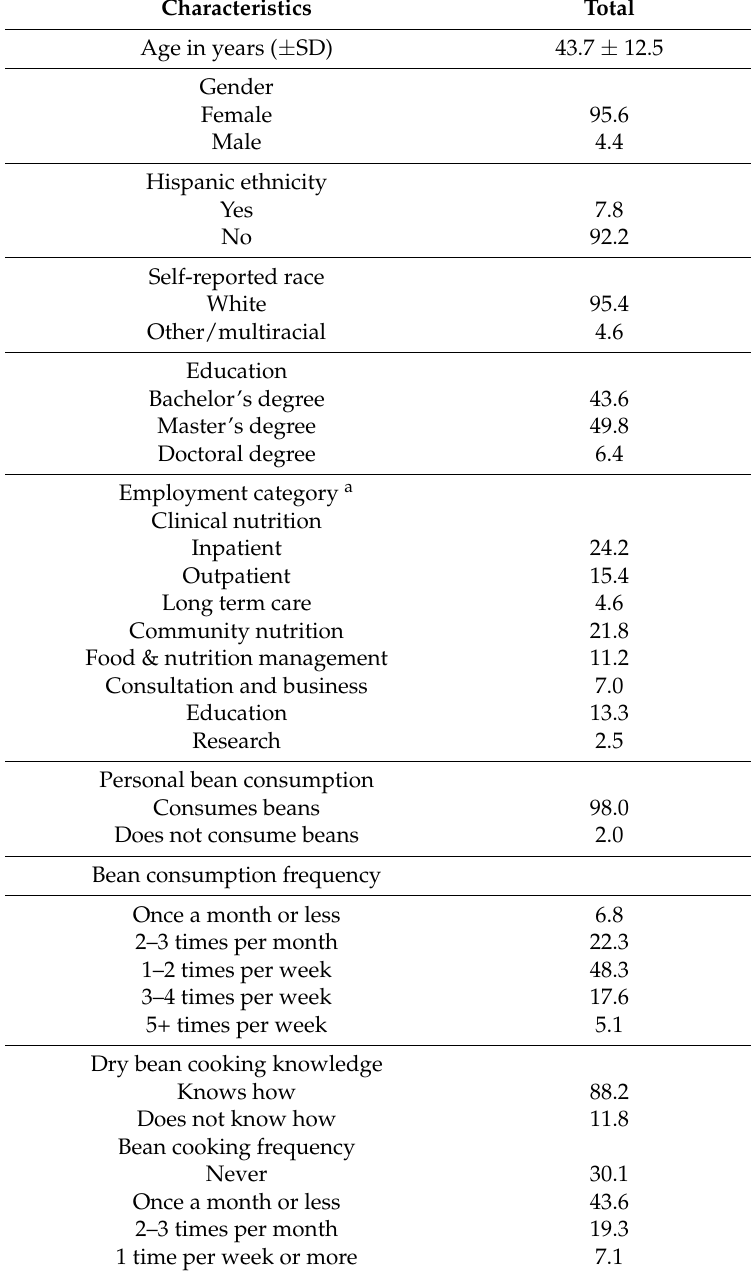
Table 1. Distribution of demographic, employment and personal bean practices of Arizona Registered Dietitians ( n =